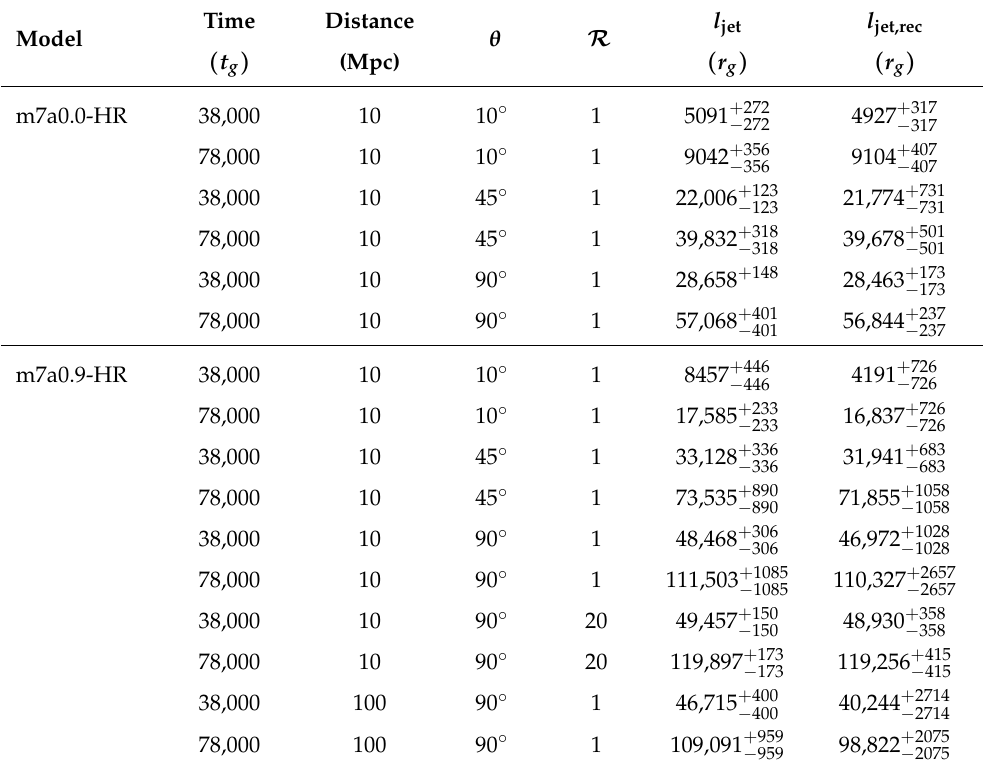
Table 3. Here we tabulate the estimated jet length for each model at each time for various choices of the distance D , viewing angle θ , and plasma temperature ratio R . We compare the jet length as computed from the base ipole image ( l jet ) and the reconstructed image ( l jet,rec